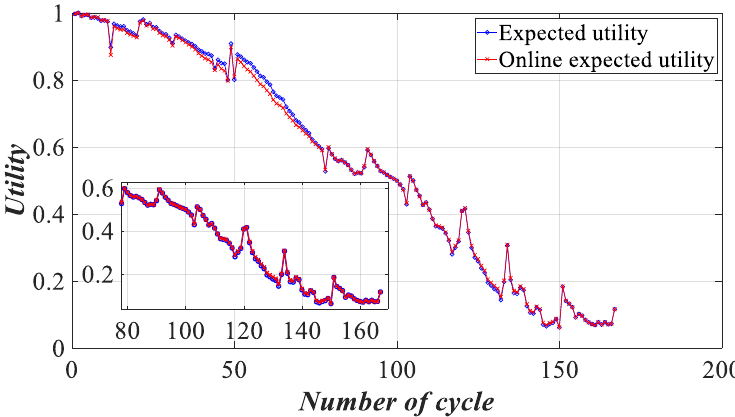
Figure 19. Weight and reliability of the observation indicators in real time.